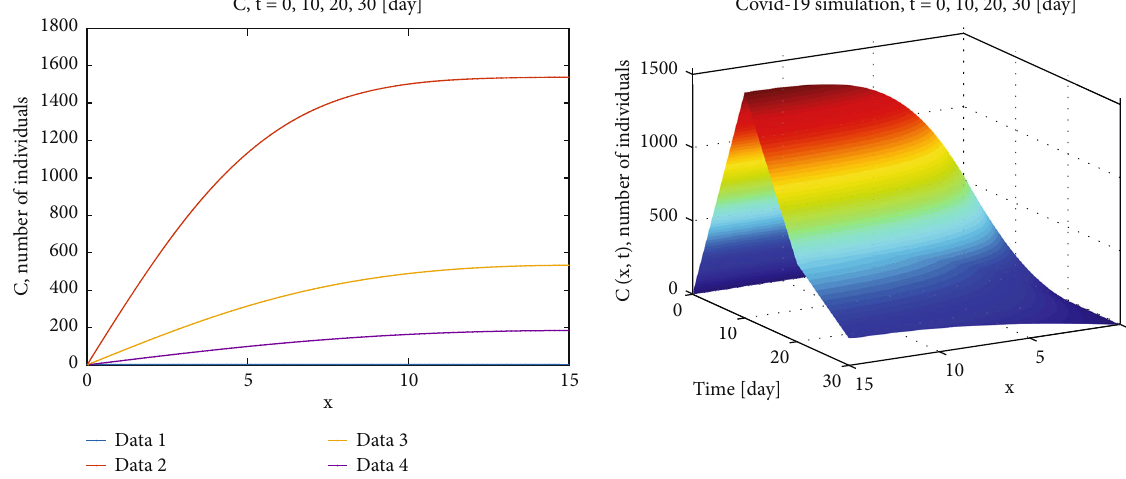
Figure 2: One section and 3-dimensional plot for the proportion of carriers (dead corpse) that transmit the COVID-19 in space and time.